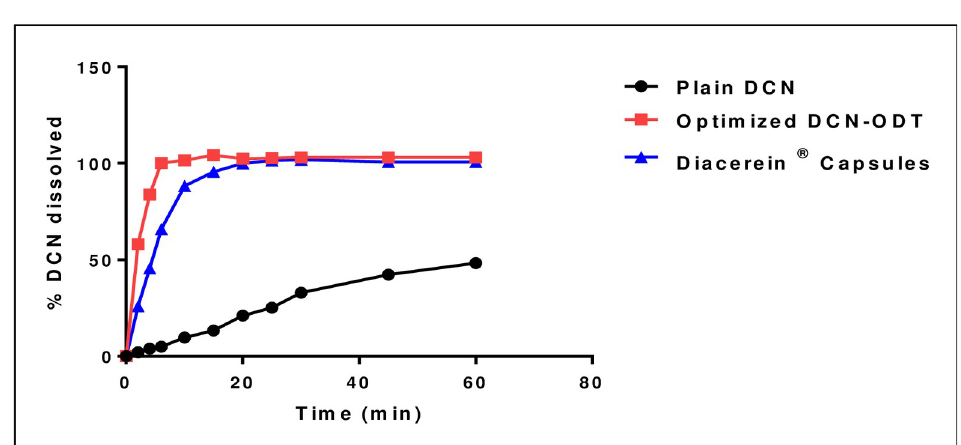
Fig 1. In-vitro mean dissolution profiles of DCN from optimized DCN-ODT (equivalent to 50 mg) compared to plain DCN and Diacerein 1 capsules in phosphate buffer (pH 6.8).